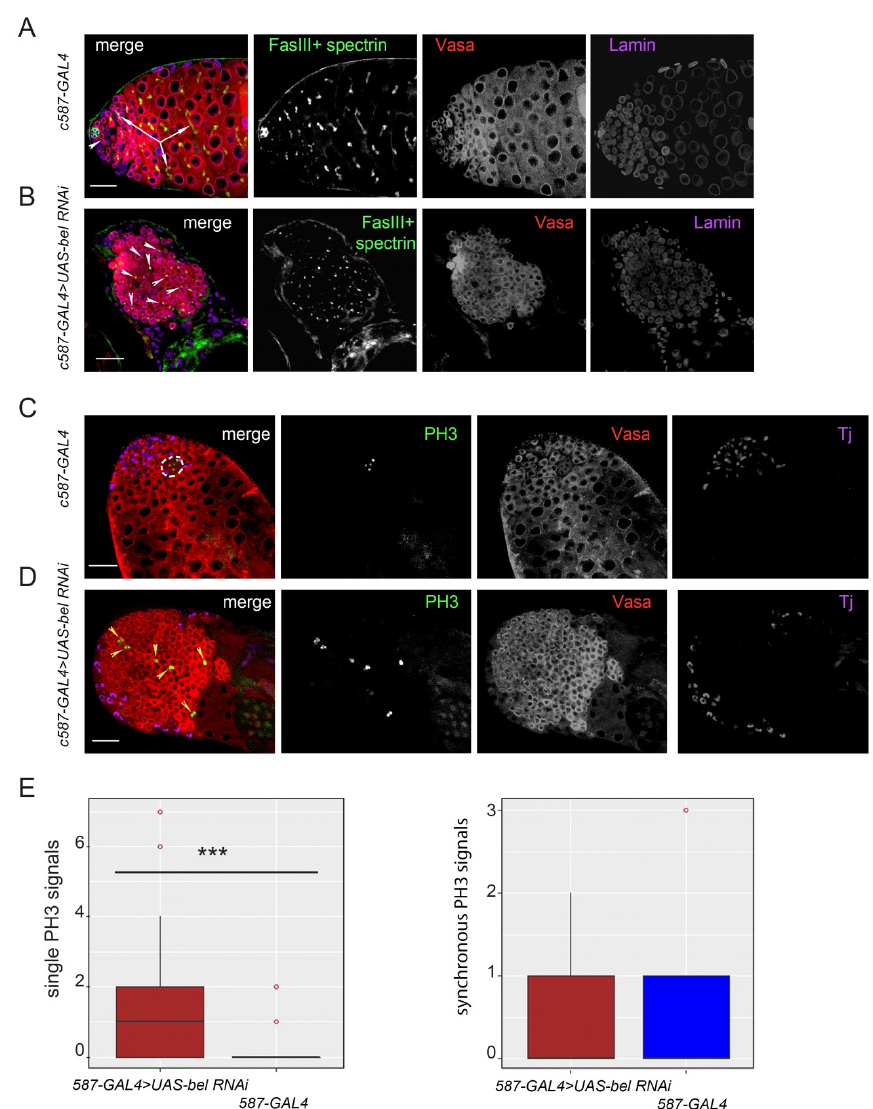
Figure 2. Analysis of germ cell proliferation activity in the clusters. ( A, B) Testes of newly eclosed males were stained with anti-Vasa (red), anti-Lamin (violet), anti-Fasciclin III (FasIII) (green), and anti- α -spectrin (green) antibodies. The Lamin staining indicates nuclear envelope positions. Internal confocal slices of the immunostained testis preparations are shown. Scale bars are 30 µm. ( A ) Control testes of c587-GAL4 males display a wild-type pattern of spectrosomes (white arrowheads) and fusomes (white arrows). A black asterisk marks the FasIII-stained hub. ( B ) Germ cells in the clusters of the RNAi belKD testes contain dot-like spectrosomes (white arrowheads). ( C , D ) Testes of newly eclosed males were stained with anti-Vasa (red), Tj (violet), and anti-PH3 (green) antibodies. Internal confocal slices are shown. Scale bars are 30 µm. ( C ) Spermatogonial cells in the cysts of the control testes undergo synchronous divisions (outlined region). ( D ) Germ cells in the clusters of RNAi belKD testes divide independently of each other and asynchronously (yellow arrowheads). ( E ) Boxplot diagrams show the numbers of PH3 signals in germ cells per testis calculated for the testes of c587-GAL4 > UAS-bel RNAi flies ( n = 20) and control c587-GAL4 testes ( n = 18). Statistically significant di ff erences (***) were found between the two groups for single signals (left diagram) by Wilcoxon / Mann–Whitney two-sided test, p = 0.0093. For synchronous signals in germ cells (right diagram) no significant di ff erences were found between the experimental and control groups ( p =